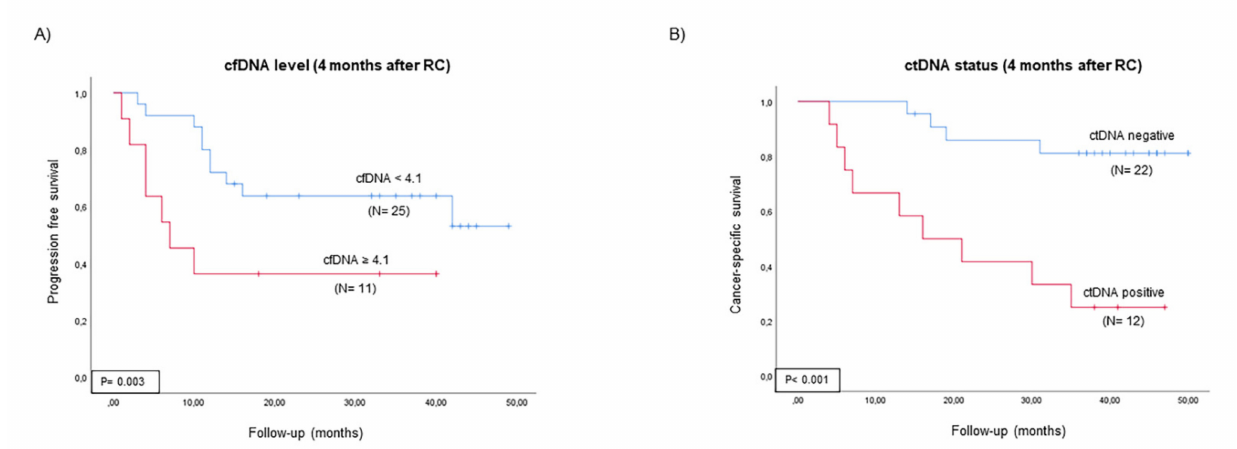
Figure 3. Prognostic value of ctDNA status and cfDNA level. Kaplan–Meier survival analysis shows probability of ( A ) tumor progression in MIBC patients stratified by cfDNA level and ( B ) CSS in MIBC stratified by ctDNA status at four months.